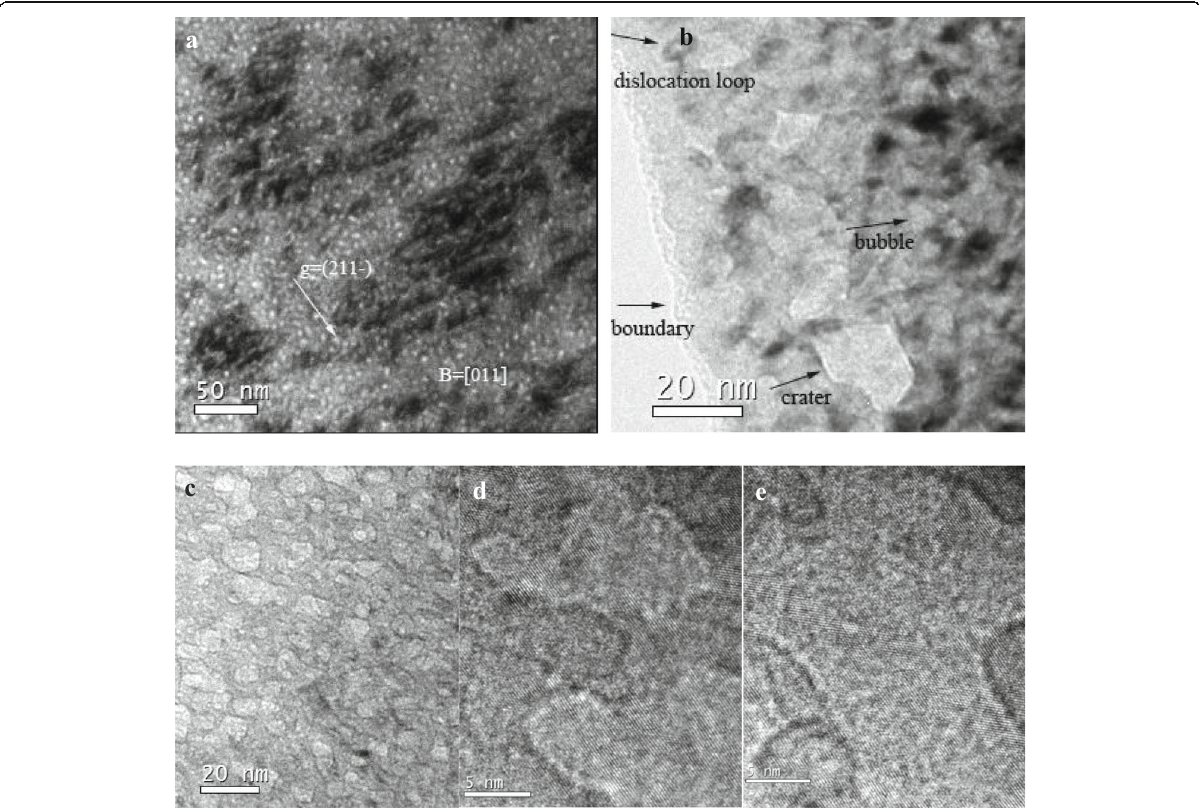
Fig. 3 Microstructures of V-4Cr-4Ti alloys after post-irradiation annealing treatment at 450 °C for 20 h. a Dislocation loops of bright field. b , c Bubbles of bright field. d , e Bubbles of high-resolution